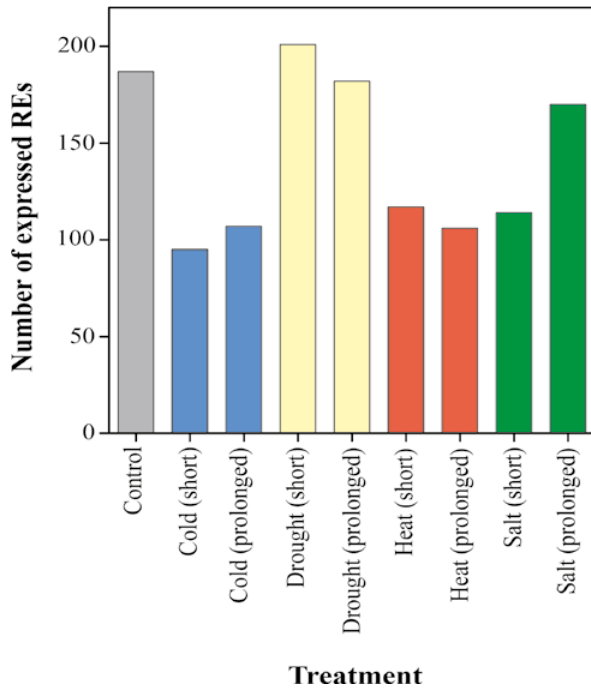
Fig. 2. Number of expressed (MRpM > 1) LTR-REs in leaves of control and stress-exposed plants. Stresses included cold, drought, heat and salt treatments, for short and prolonged